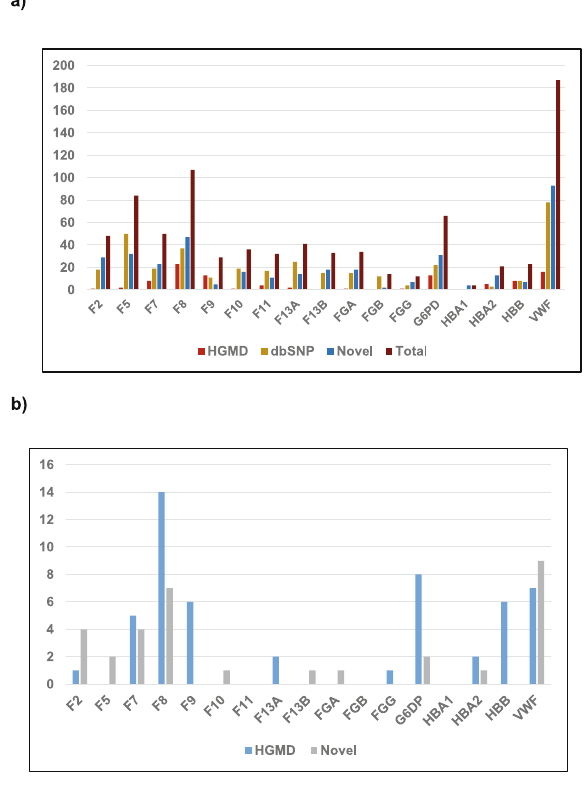
Fig. 1 Count and classi fi cation of variants identi fi ed in P-Cohort. a Count of HGMD, Novel variants and polymorphisms/ gene (generated from Supplementary Table 2). b Number of Pathogenic and likely pathogenic HGMD and novel mutations. (generated from Supplementary Tables 3 and